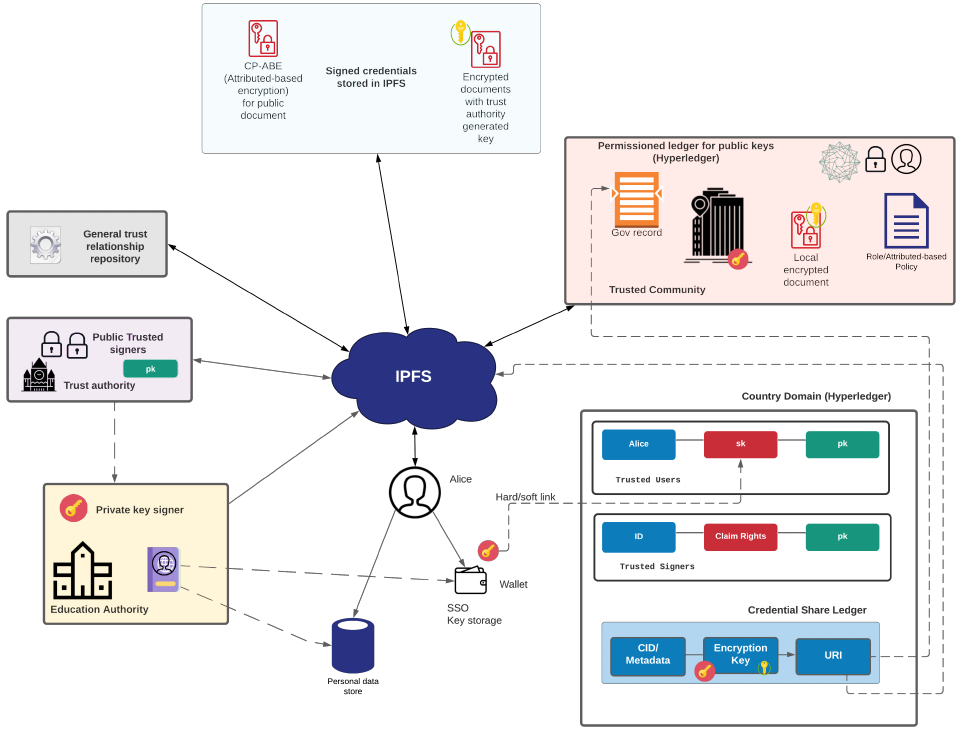
Figure 2. Data sharing